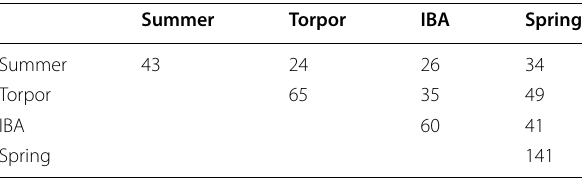
Table 4 The number of core OTUs in mucosa microbiotas of each captive group and shared between